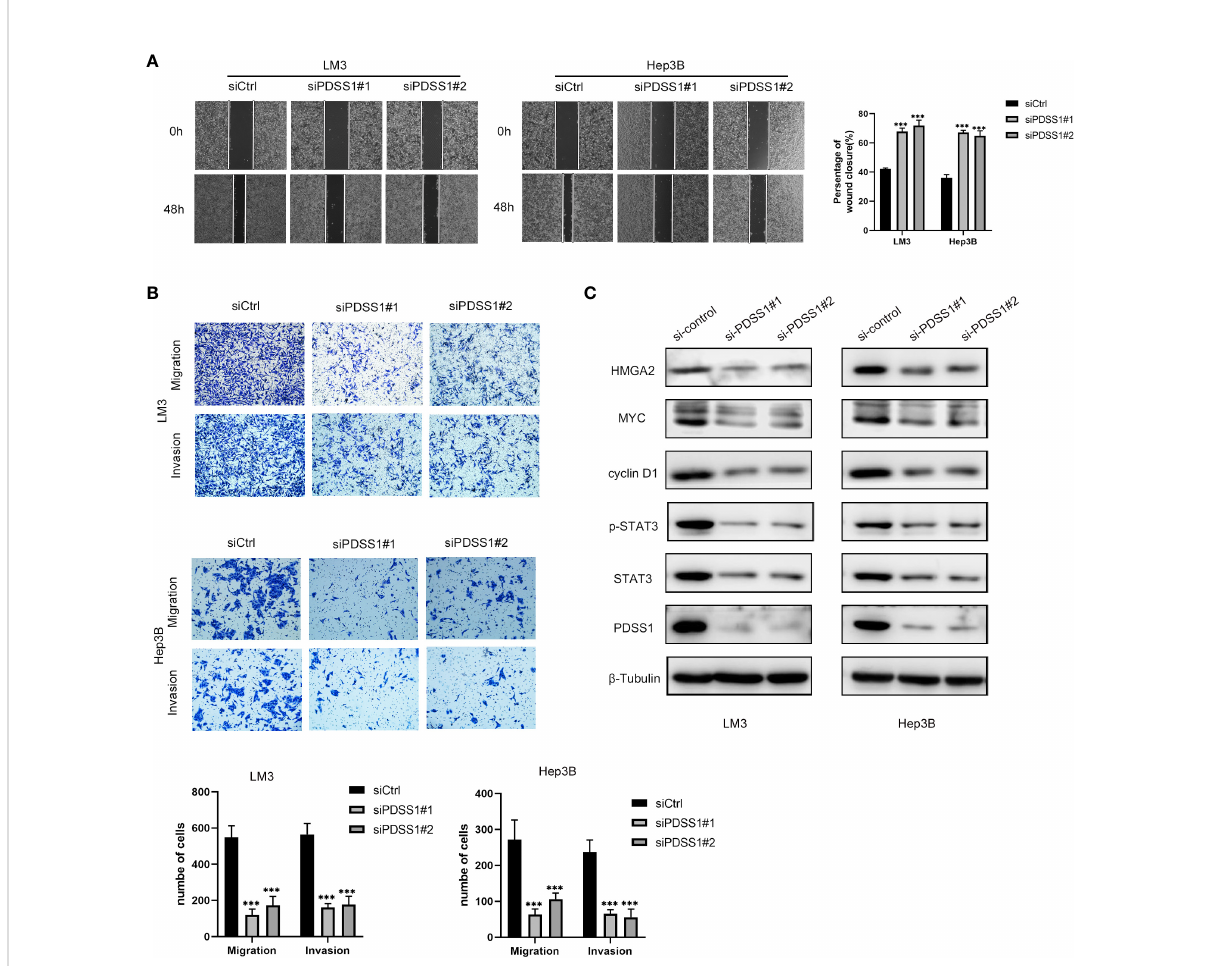
FIGURE 7 Knockdown of PDSS1 inhibited the proliferation, cell cycle, migration and invasion of HCC cells. (A, B) Wound healing assay and Transwell assays were used to detect the invasion and migration ability of LM3 and Hep3B cells transfected with siCtrl or siPDSS1. (C) The expression levels of indicated proteins were evaluated by WB in LM3 and Hep3B cells transfected with siCtrl or siPDSS1. Data are expressed as the mean ± SD of three individual experiments. *** p <